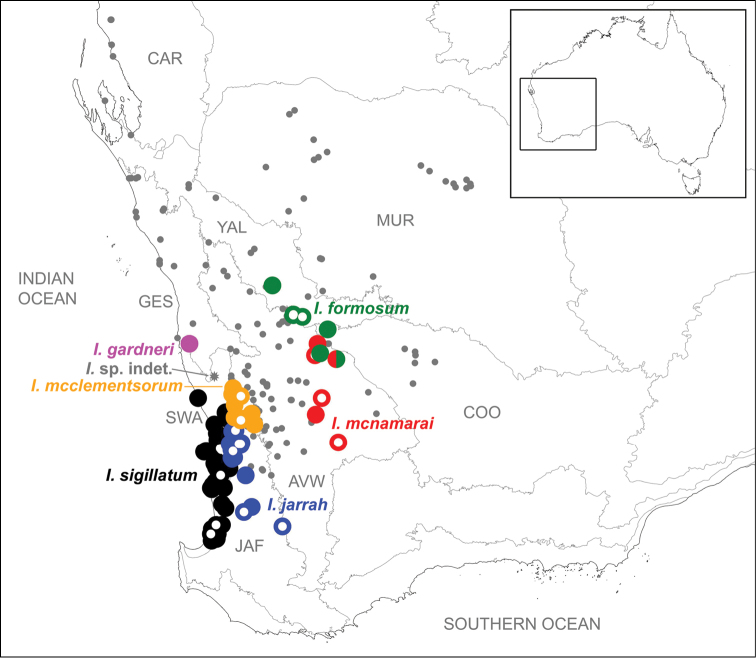
Map showing collection records of non-‘sigillate complex’ Idiosoma species in the sigillatum-clade from south-western Australia; base map shows collection records for all other species in the nigrum-group as smaller grey dots. Specimens sequenced for the molecular analyses are denoted by open circles, and relevant IBRA 7.0 bioregions are as follows: AVW, Avon Wheatbelt; CAR, Carnarvon; COO, Coolgardie; GES, Geraldton Sandplains; JAF, Jarrah Forest; MUR, Murchison; SWA, Swan Coastal Plain; YAL, Yalgoo.